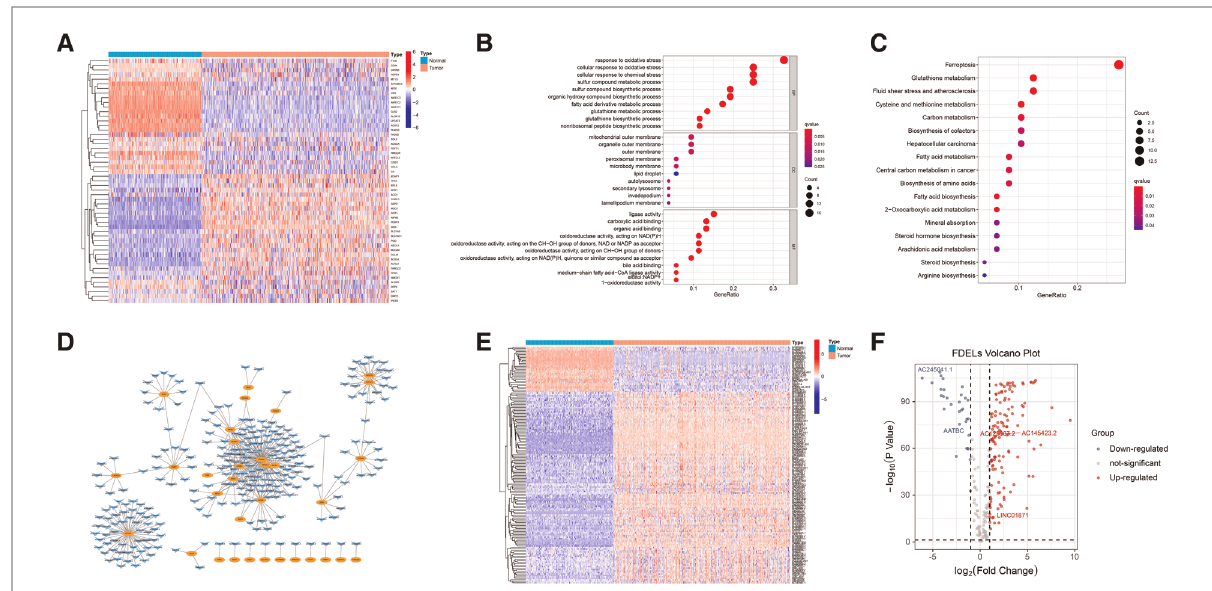
FIGURE 1 FDEG and FDEL identi fi cation and functional enrichment analyses. ( A ) The heatmap illustrates 53 FDEGs. ( B ) GO analysis of the FDEGs. ( C ) KEGG analysis of the FDEGs. ( D ) Co-expression network of FDEGs and FDELs. Yellow nodes indicate FDEGs; blue arrows FDELs. ( E,F ) A heatmap and volcano plot show 161 FDELs and 5 studied